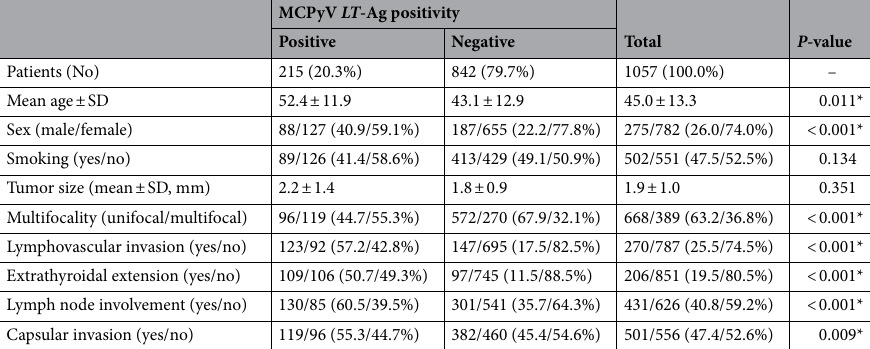
Table 1. Demographic features in Iranian Patients with papillary thyroid cancer according to MCPyV LT -Ag positivity. SD standard deviation, mm millimeter. *Statistically significant (< 0.05).